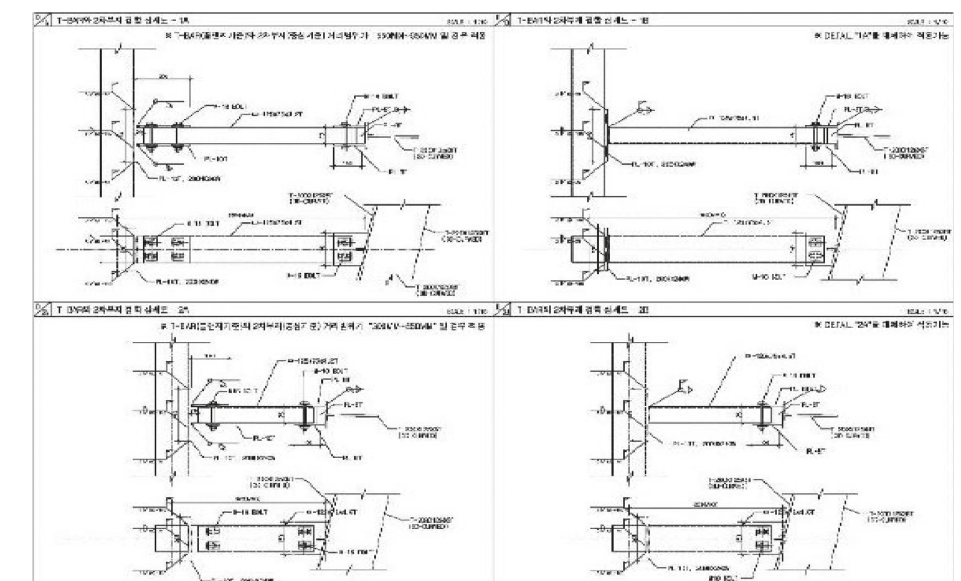
Figure 10: Fabrication shop drawings of CNC T-BAR and secondary steel structure extracted from the fabrication BIM model.